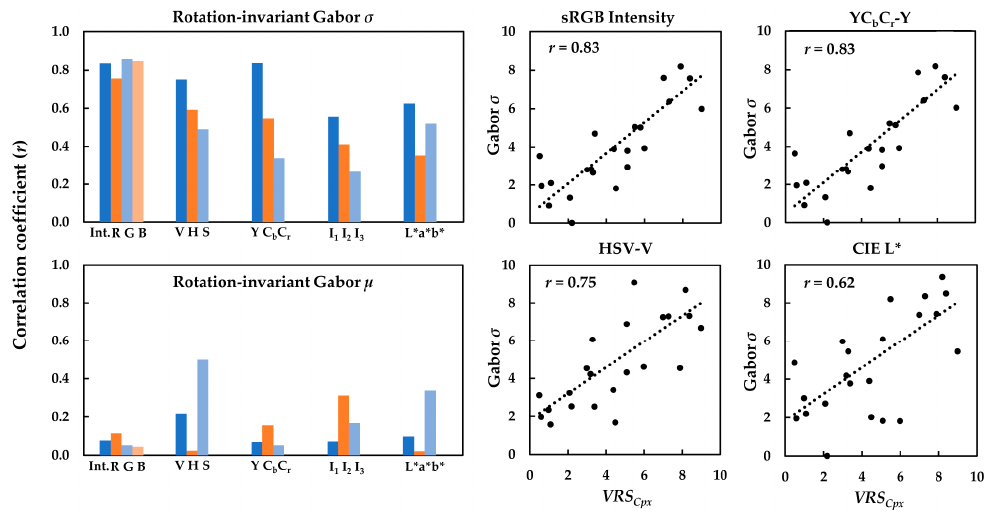
Figure 18. The correlation between the VRS Cpx of the textiles and the Gabor σ and Gabor µ computed for the luminance and chrominance channels of the textile images with the frequency F = 0.18 in the sRGB, HSV, YC b C r , I 1 I 2 I 3 , and CIELAB color spaces. Here, ‘Int.’ refers to the sRGB intensity image ( left ). Scatter plots of the Gabor σ versus the corresponding VRS Cpx for the luminance channel of the textile images in the sRGB HSV, YC b C r , and CIELAB color spaces ( right ).